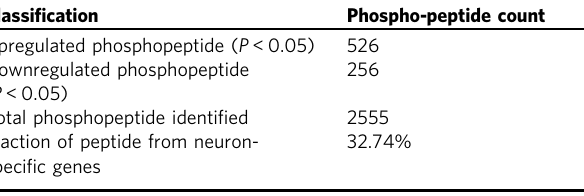
Table 1 The fraction of neural genes included in the phosphoproteomic